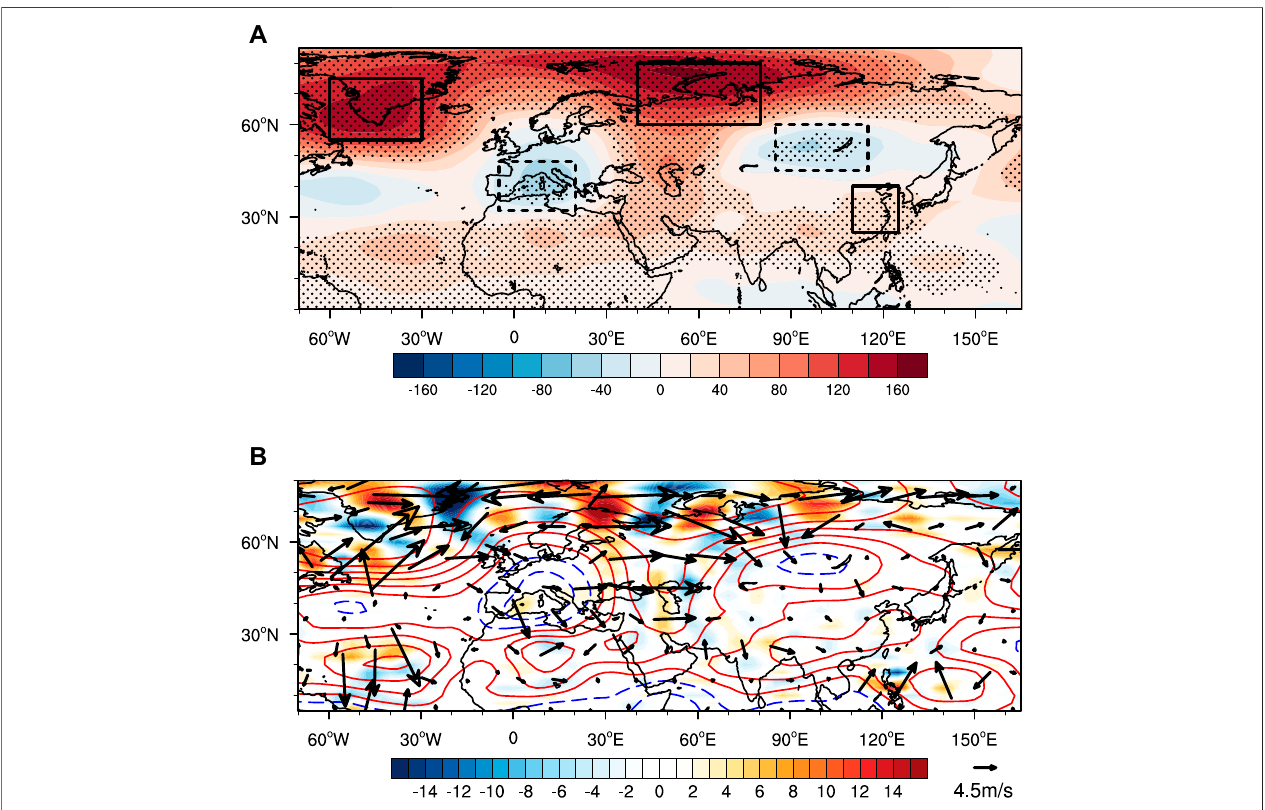
FIGURE 4| (A) Regression ofthe winter 500 hPa geopotential height (shading, units: gpm · K − 1 ) on the AMO index from 1979 to2018. The stippled indicate values exceeding the 95% con fi dence level. (B) As in (A) , but for 500 hPa streamfunction (contour, units: 106 m 2 · s − 1 · K − 1 , intervals are 2, from − 11 to 11) and the streamfunction ’ s wave fl ux (vector; units: m 2 · s − 2 ) and the divergence of wave fl ux (shading; units: 10 − 5 m · s − 2 ).